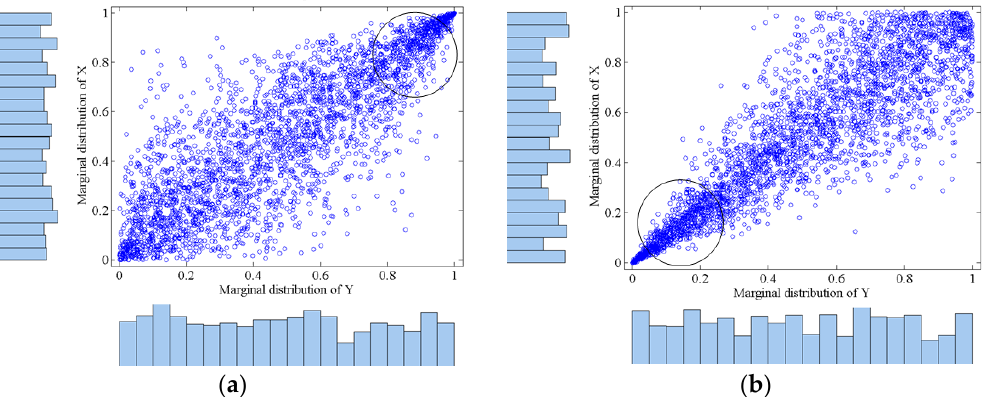
Figure 7. Cumulative distribution function and marginal distribution of random variables in the forms of: ( a ) Gumbel; and ( b ) Clayton copula.